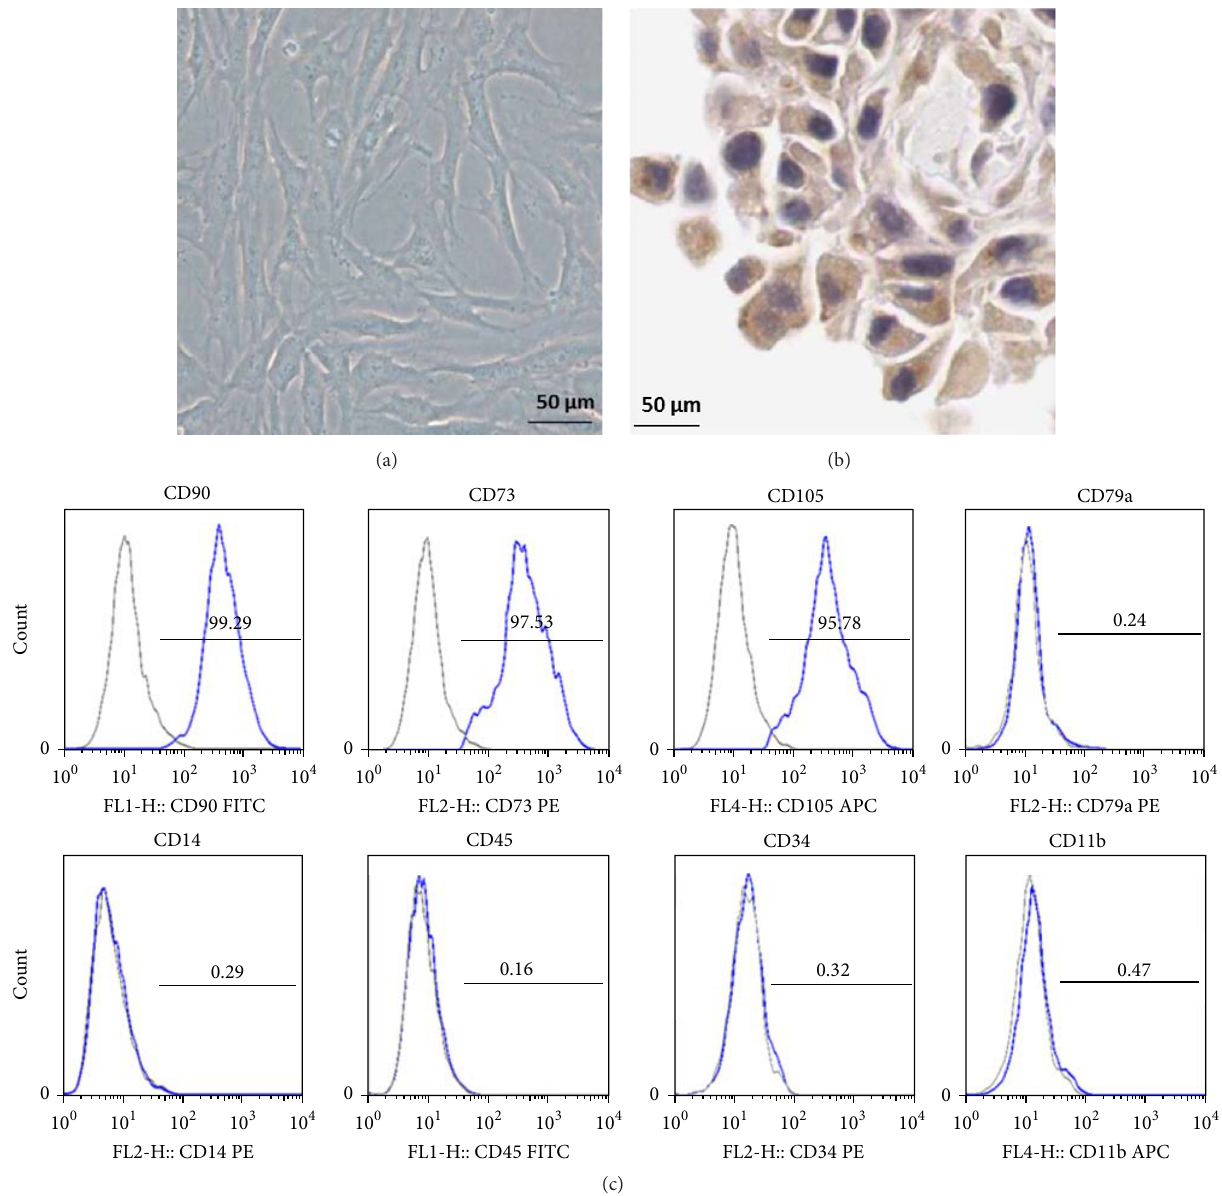
Figure1:PDLSCsidentifiedbymorphologicanalysis,immunocytochemicalstaining,andflowcytometry.(a)MorphologyofPDLSCs( × 100). (b) PDLSCs positive for vimentin in cytoplasm (streptavidin biotin peroxidase complex stain, original magnification × 200)